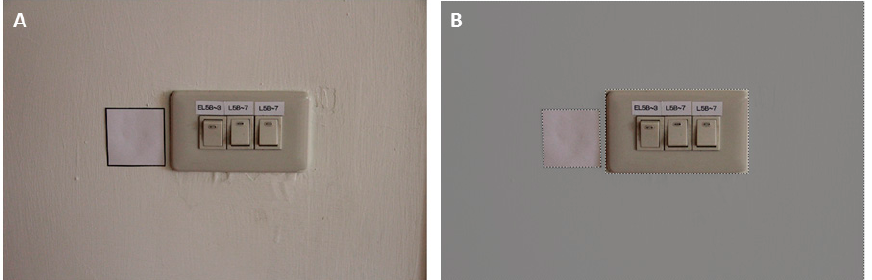
Figure 1. Raw ( A ) and processed photographs ( B ) that were used to determine the surface area of a light switch. The number of pixels in the reference paper (5 × 5 cm) and the surface of interest were calculated using the processed photographs. The equation used to calculate the surface area is described in the Methods